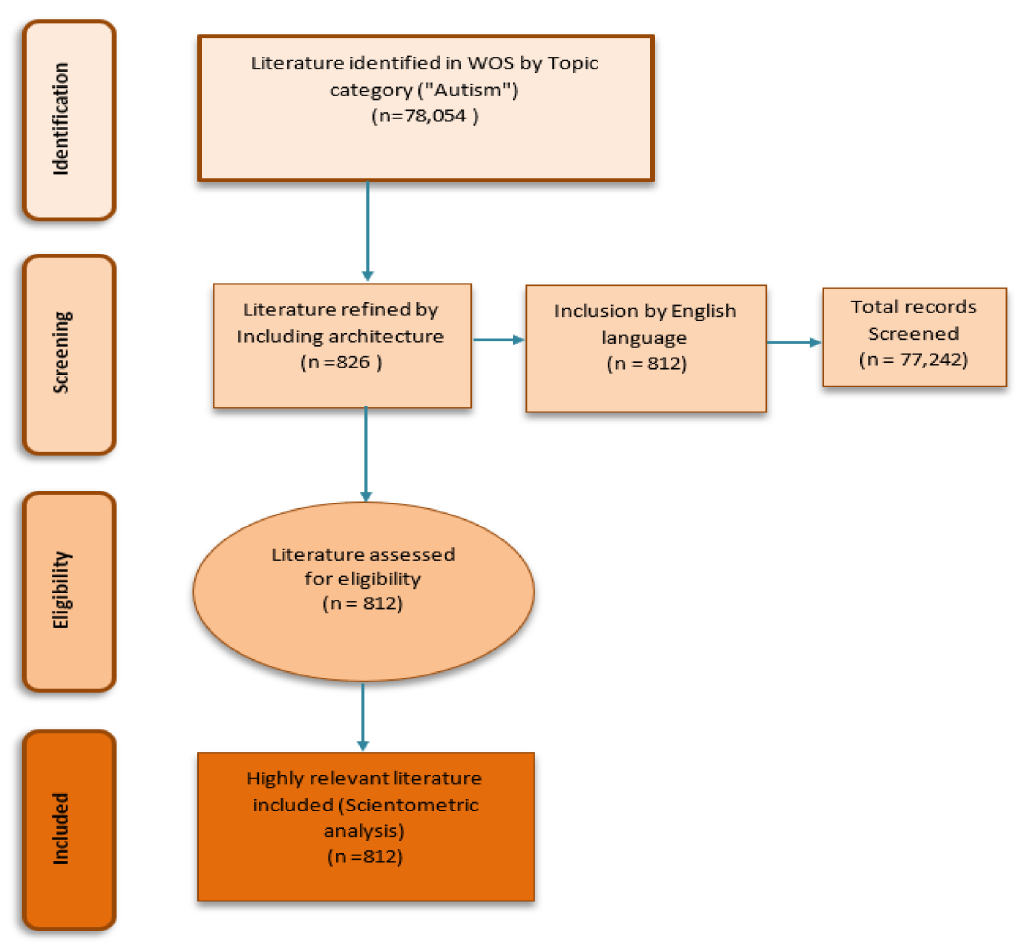
Figure 1. Four phase flow chart of data extraction and filtration